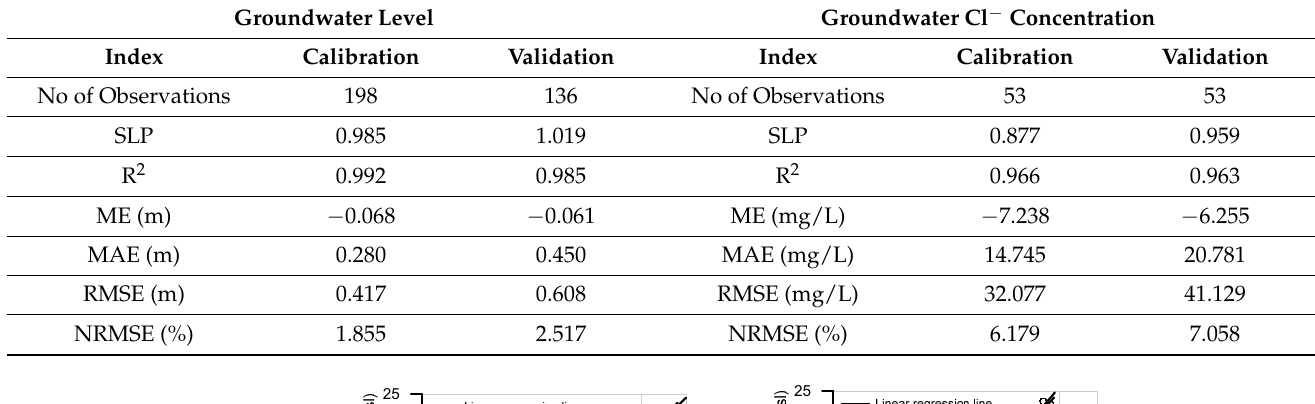
Table 2. Statistical indices of model performance evaluation during calibration and validation periods.